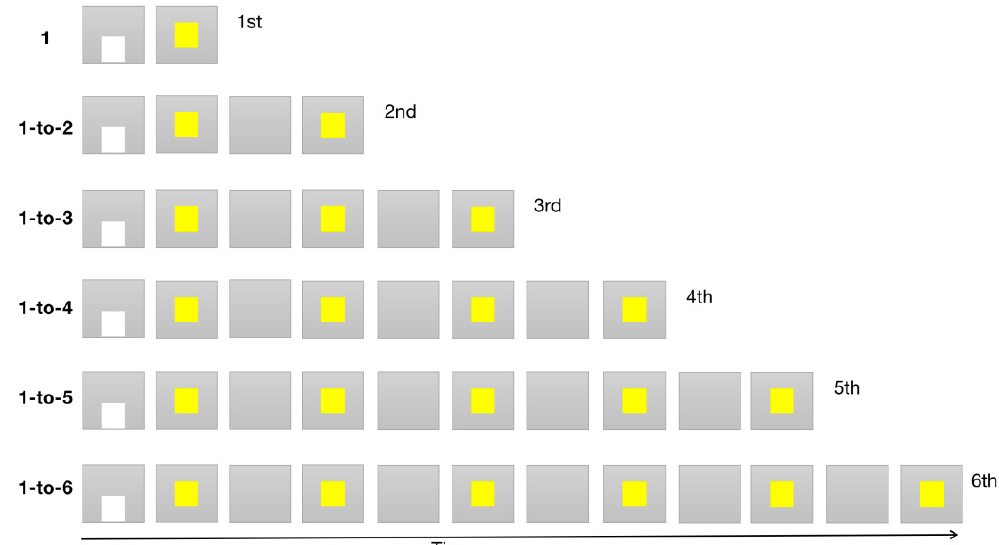
Figure 1. The 6 counting task protocols. Each task was started by touching the white square pattern (starting signal), then one or multiple yellow square pattern(s) sequentially appeared on the center of the screen, with 0.5–1.5 s interpattern intervals. In each task, the monkeys were required to make a response to a target pattern that appeared at a given ordinal position, inhibiting responses to patterns appearing at other ordinal positions. For example, they had to touch the 1st pattern in the 1-counting task, the 2nd pattern in the 1-to-2 counting task, the 3rd pattern in the 1-to-3 counting task, and so on. Ultimately, the monkeys learned to touch the 6th pattern in the 1-to-6 counting task.